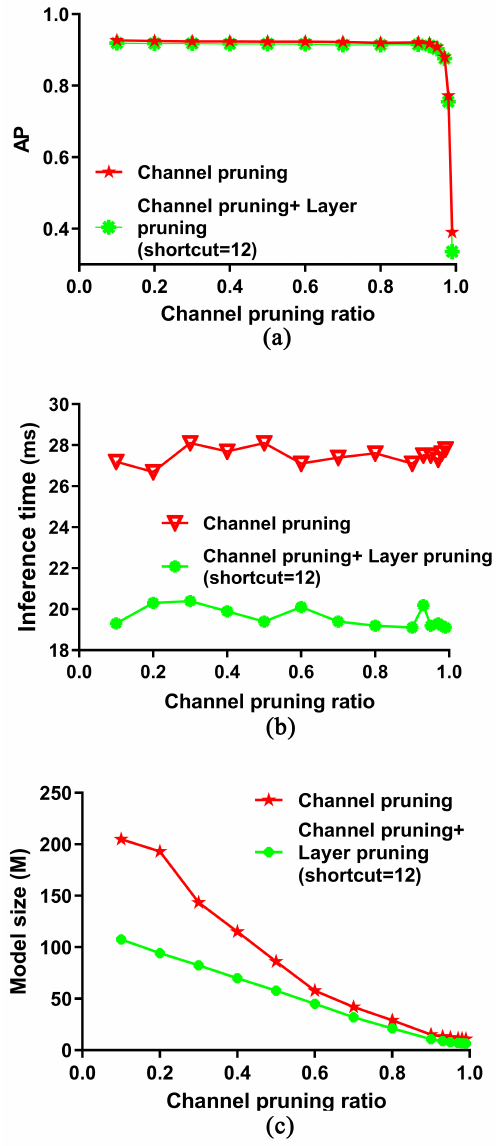
Figure 8. Influence of layer pruning and channel pruning: ( a ) AP curve, ( b ) inference time and ( c ) model